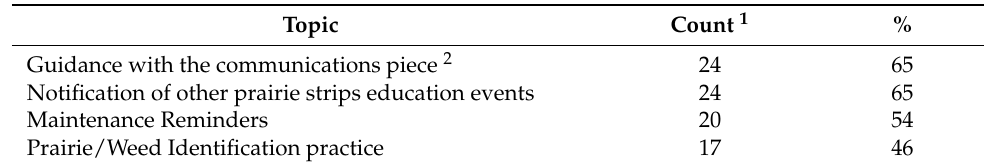
Table 5. Additional supports listed as check-all-apply question regarding from the prairie